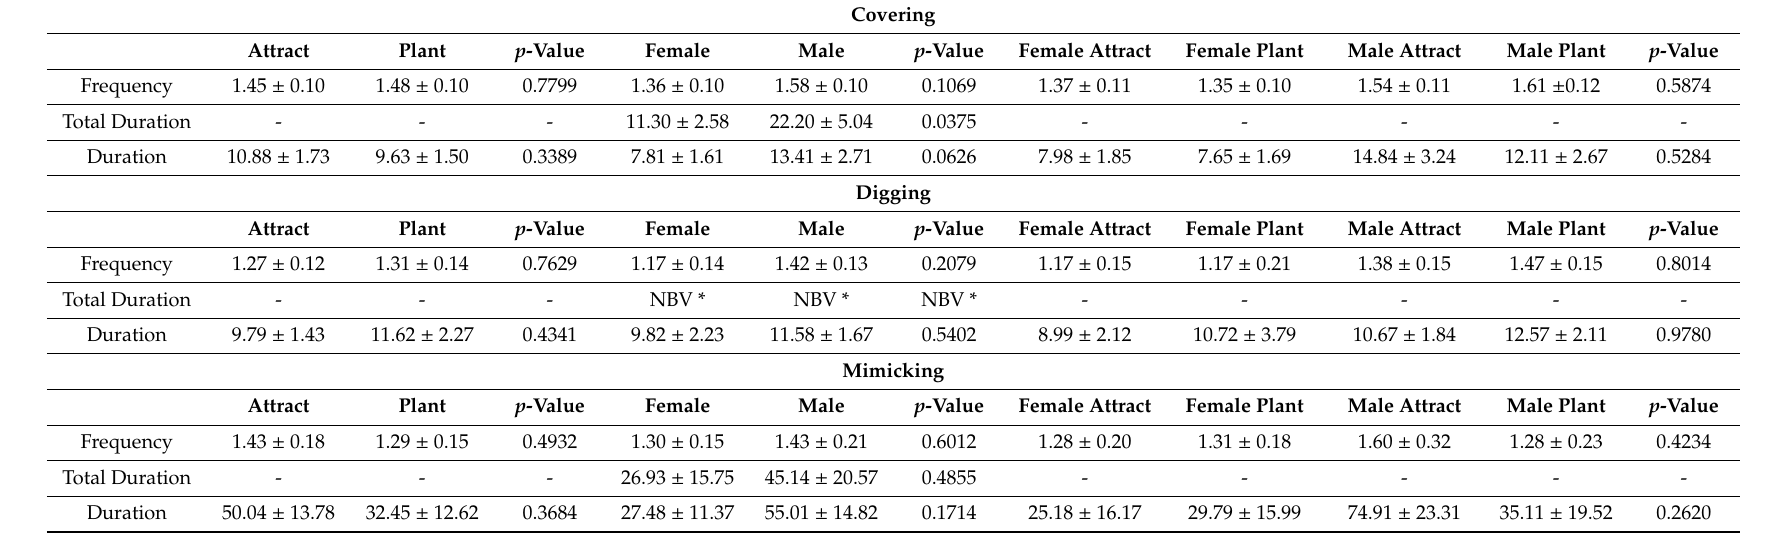
Table 3. Least square means ( ± Standard Deviations (SD) for frequency, total duration and duration of covering, digging and mimicking